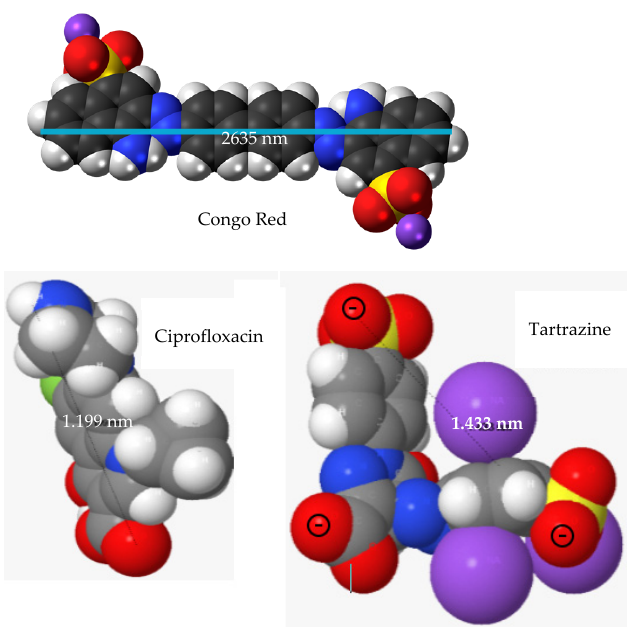
Figure 5. Steric configuration of pollutants models. The concentration of Congo Red in the permeate decreased from 20 mg/L to 0.2 mg/L and remained stable throughout the filtration time. The Figure 6 shows that the pressure does not have a visible effect on the membrane retention of the Congo Red.